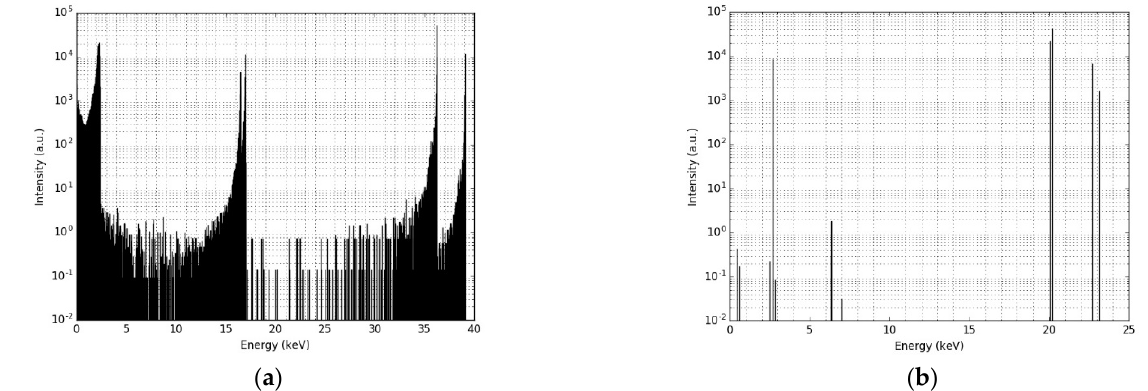
Figure 5. The energy spectra of: ( a ) the electrons leaving a nanoparticle of 25 nm radius (5 nm palladium core plus 20 nm iron oxide shell); and ( b ) the photons leaving the same nanoparticle. The simulation started all particles emitted homogeneously throughout the palladium core in the middle of the nanoparticle.